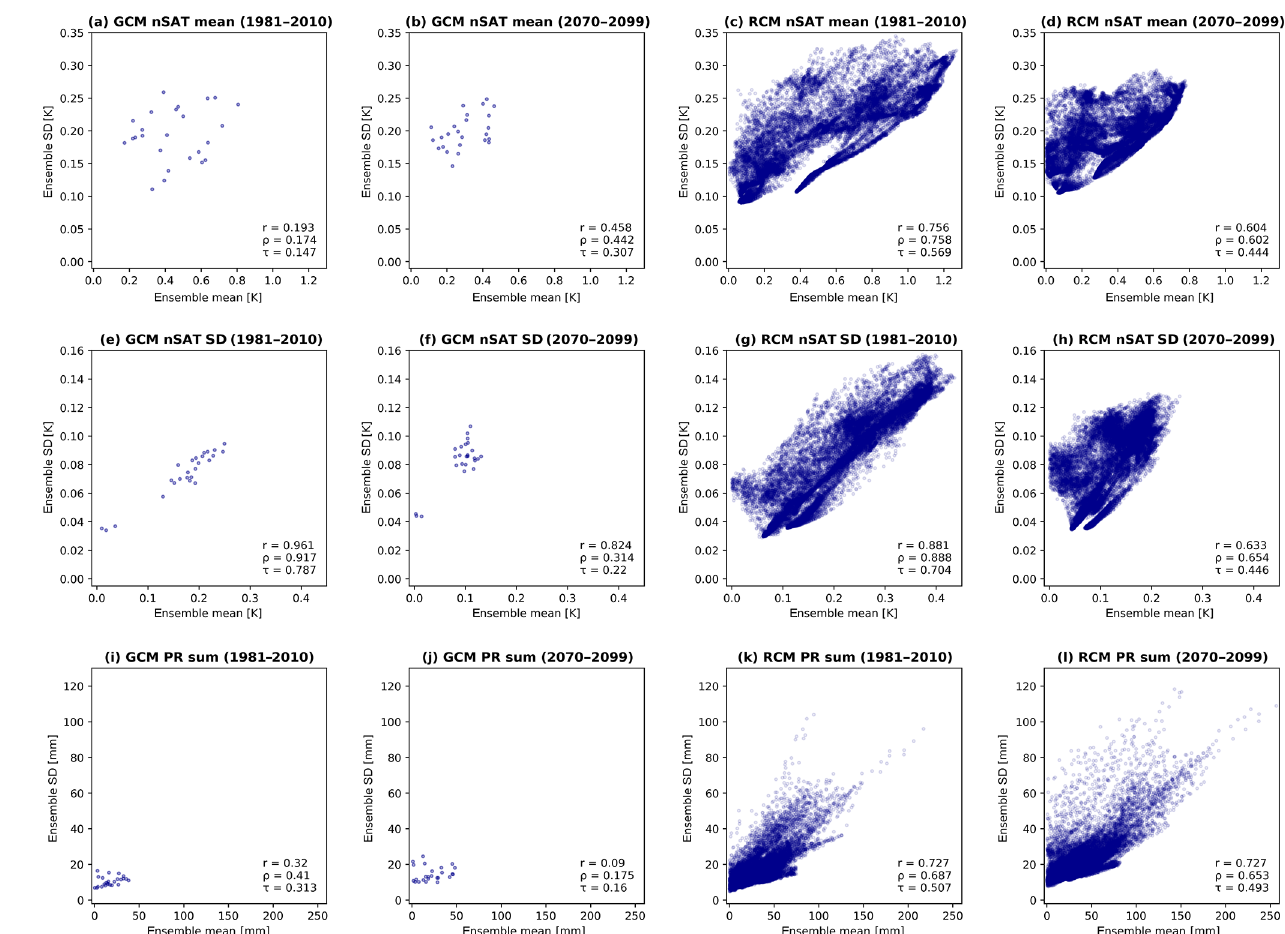
Figure A3. Relationship between LE mean and SD values of CanESM2-LE (GCM) and CRCM5-LE (RCM) for variables nSAT mean (a–d) , nSAT SD (e–h) , PR sum (i–l) for hist and fut periods. Lower right corner: r – Pearson correlation coefficient, ρ – Spearman rank correlation coefficient, τ – Kendall’s